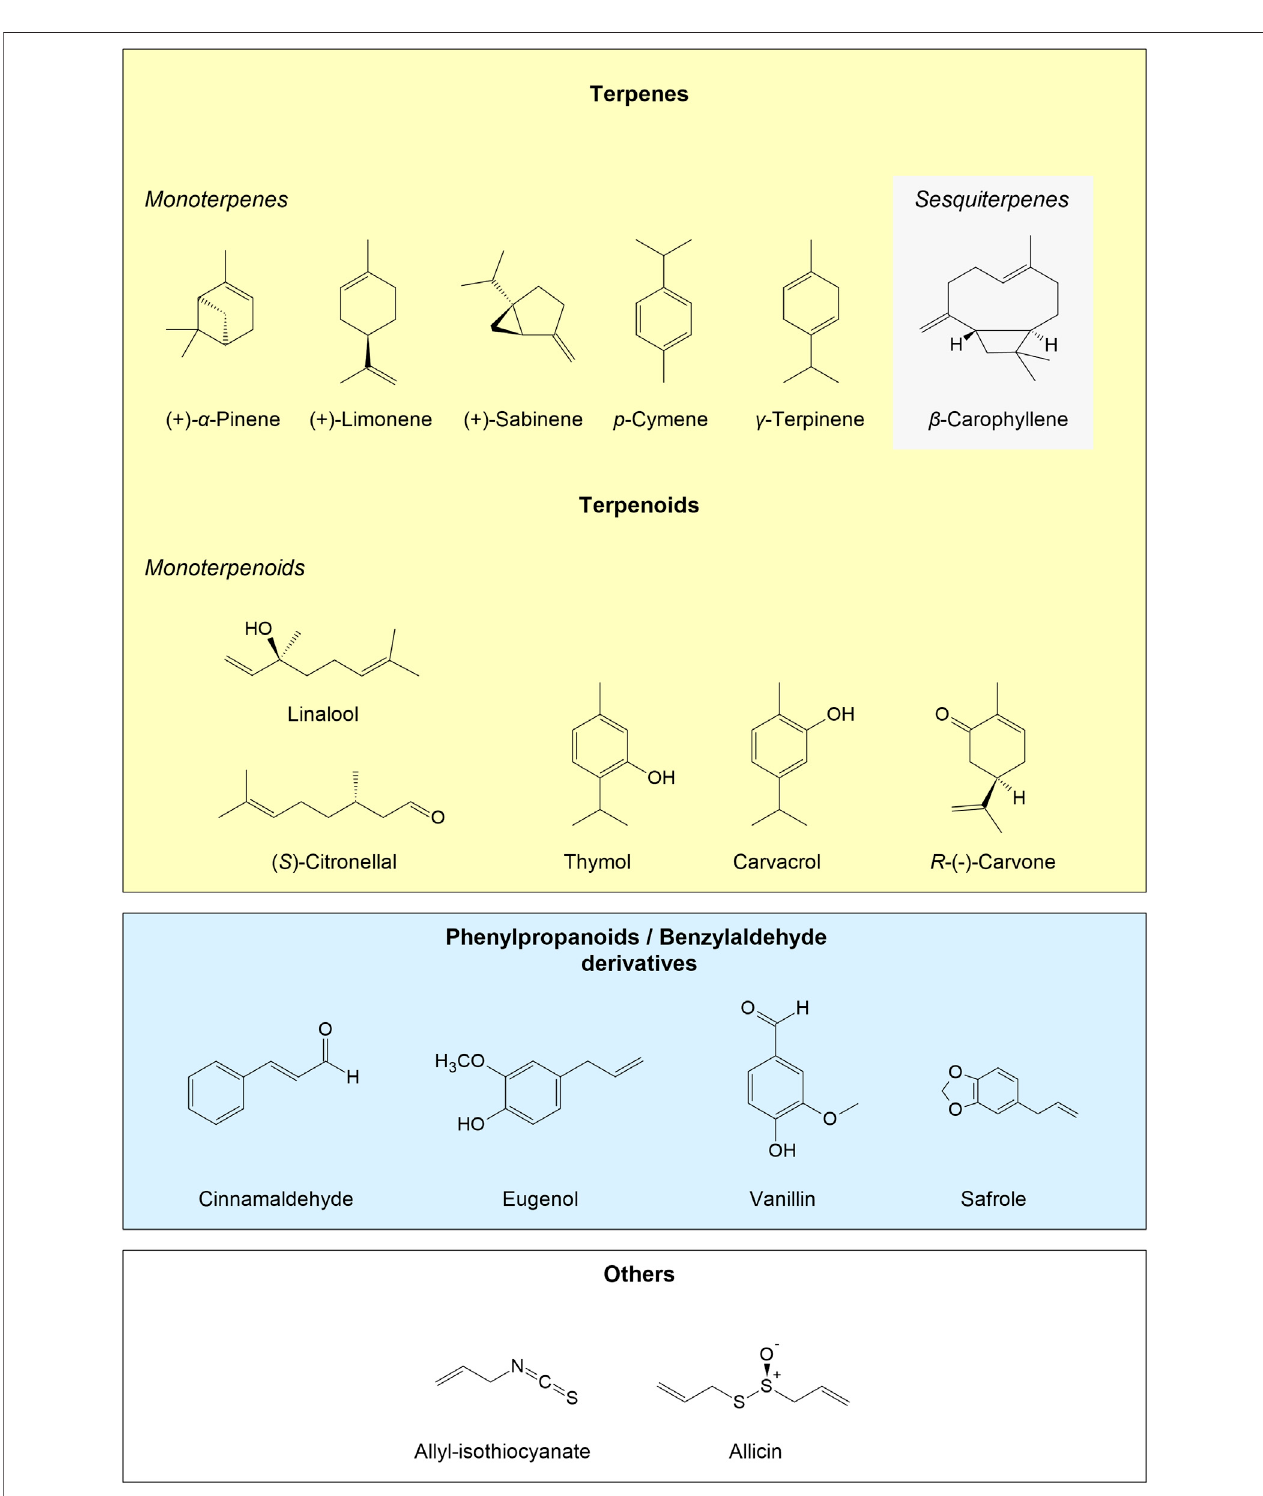
FIGURE 3 | Examples of chemical structures of EO constituents. Modi fi ed according to Hyldgaard et al. (2012).